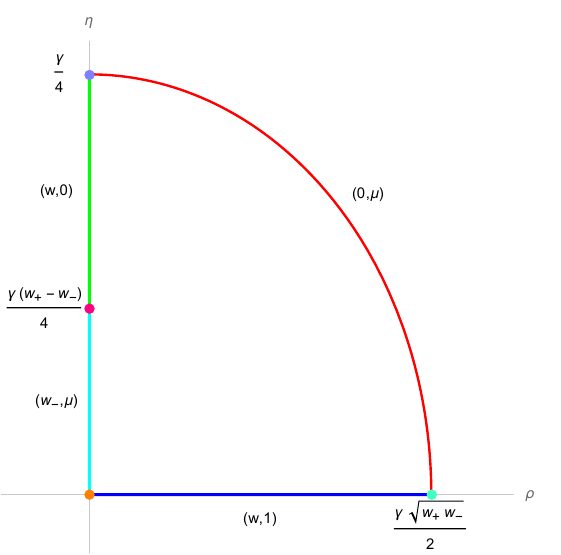
Figure 2. We plot the region in ( ρ, η ) space where the electrostatic problem is defined. The coloured segments correspond to the different faces of the rectangle in ( w, µ ) space, see figure 1. The points are the vertices of this rectangle in ( w, µ ) space. Starting with the origin and going clockwise they are: orange= ( w − , 1) , magenta= ( w − , 0) (monopole), violet= (0 , 0) , cyan= (0 , 1) . The red line forming the ellipse is the location of the smeared brane, whilst the magenta dot (lying on the η -axis at the focus point of the ellipse) arises due to the presence of a